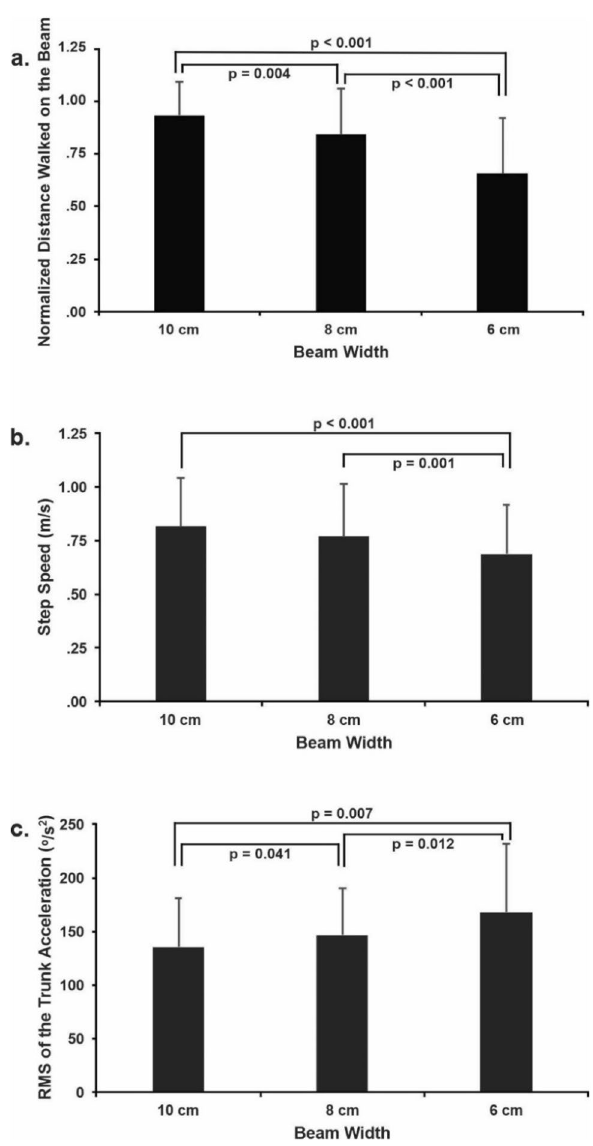
Figure 1. Mean and standard deviation of the beam width main effect for the normalized walking distance on the beam ( a ), step speed ( b ), and RMS of the trunk acceleration ( c ). The horizontal lines indicate pairwise differences with the respective p